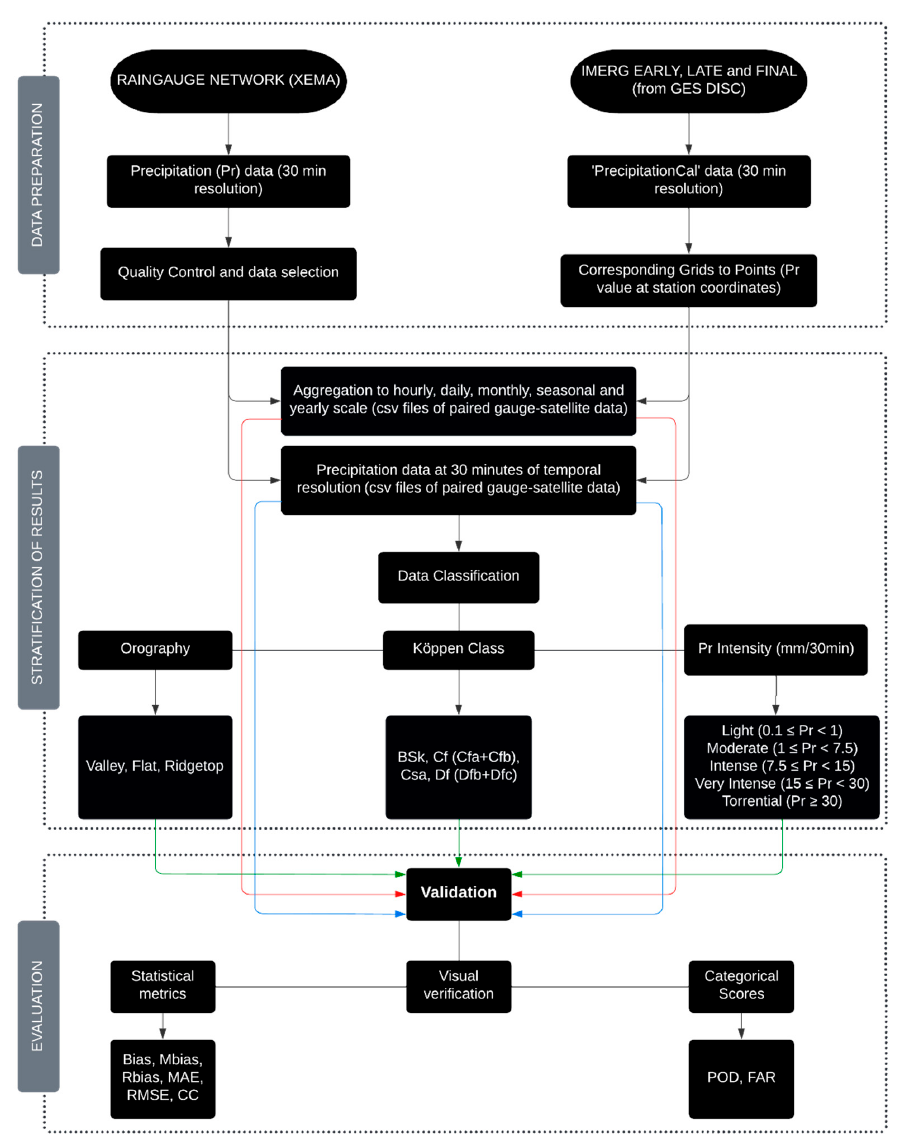
Figure 2. Schematic methodology applied in the data preparation, classification, and validation.